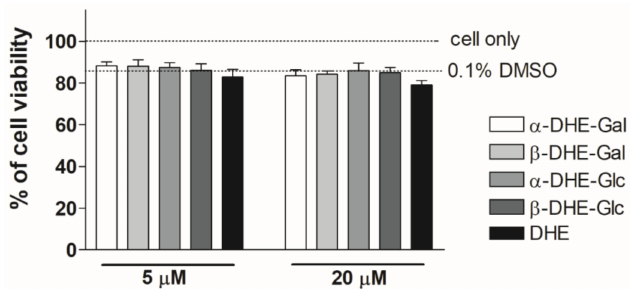
Figure 2. Effects of α - and β -anomers of DHE-Glc ( 2 and 4 ) and DHE-Gal ( 3 and 5 ) on HaCaT cell viability. HaCaT cells were treated with synthetic α - and β -anomers of DHE-Glc and DHE-Gal, and cell viability was evaluated using an MTT assay. Cells were stabilized and then incubated for 24 h at the indicated concentrations. Results are shown as a percentage of the negative control treated with the medium alone. Each value represents the mean ± S.D.